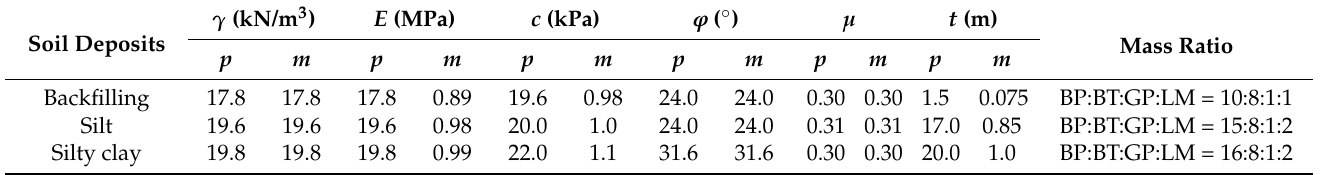
Table 1. Physical and mechanical parameters of prototype and model